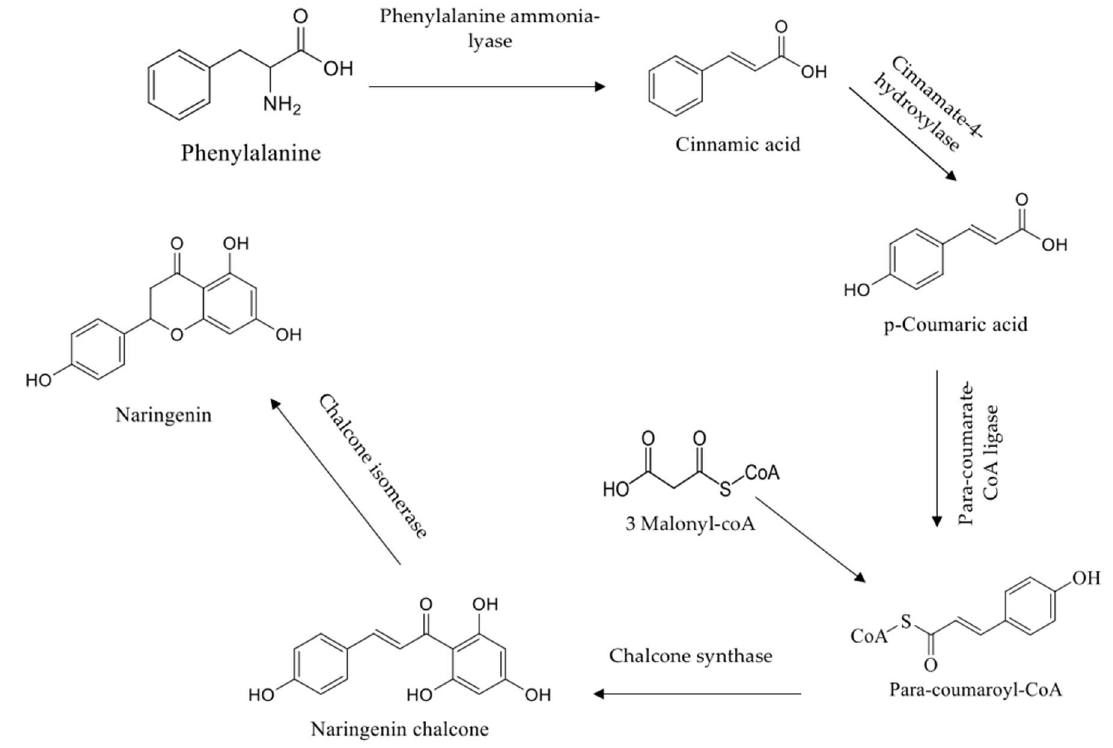
Figure 1. Naringenin biosynthesis.